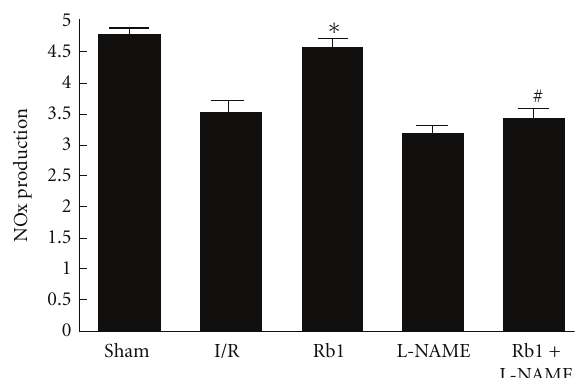
Figure 4: E ff ect of Ginsenoside Rb1 preconditioning on NO production. Results are expressed as mean ± SEM. ∗ P < 0 . 05 versus I/R group, # P < 0 . 01 versus Rb1